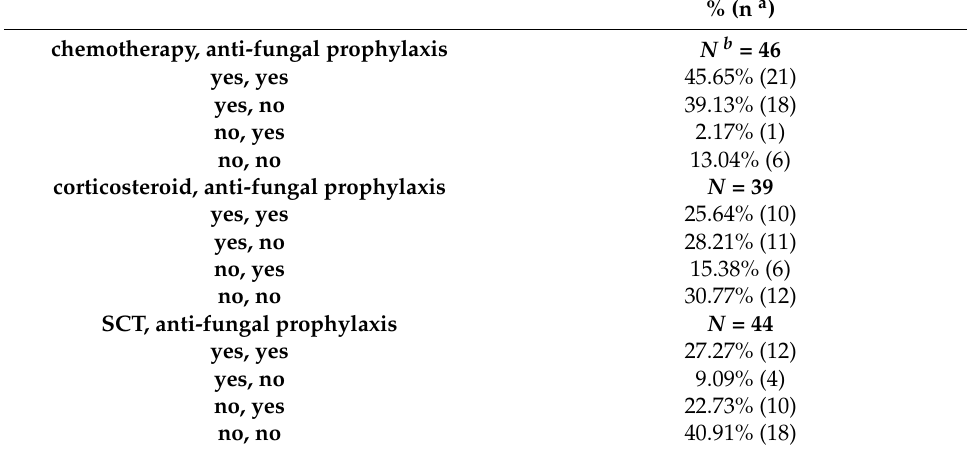
Table 6. Traditional risk factors with or without antifungal